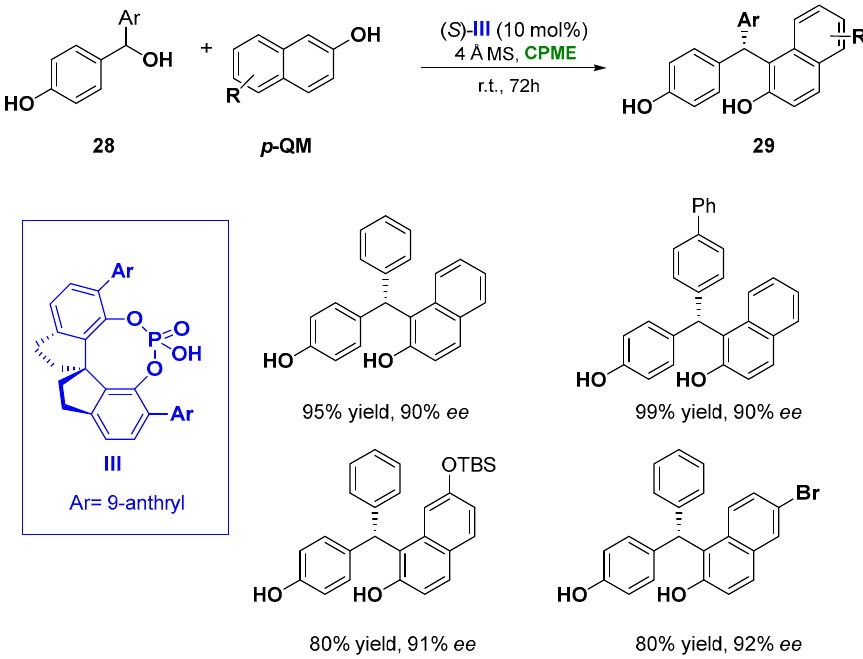
Figure 16. Asymmetric CPA catalyzed of 1,2-diaryls from naphthols and benzylic